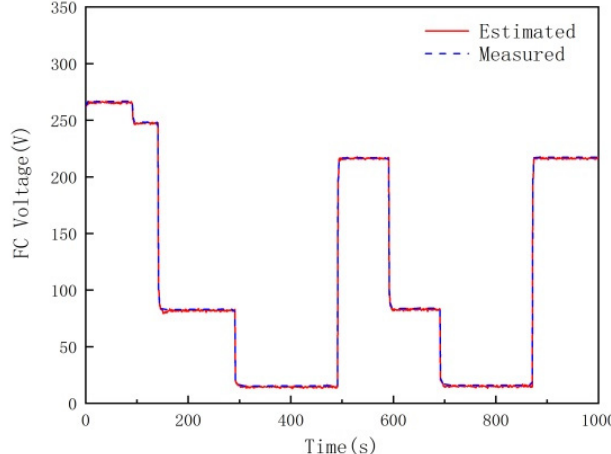
Figure 7. Comparison of the estimated voltage and the test voltage.